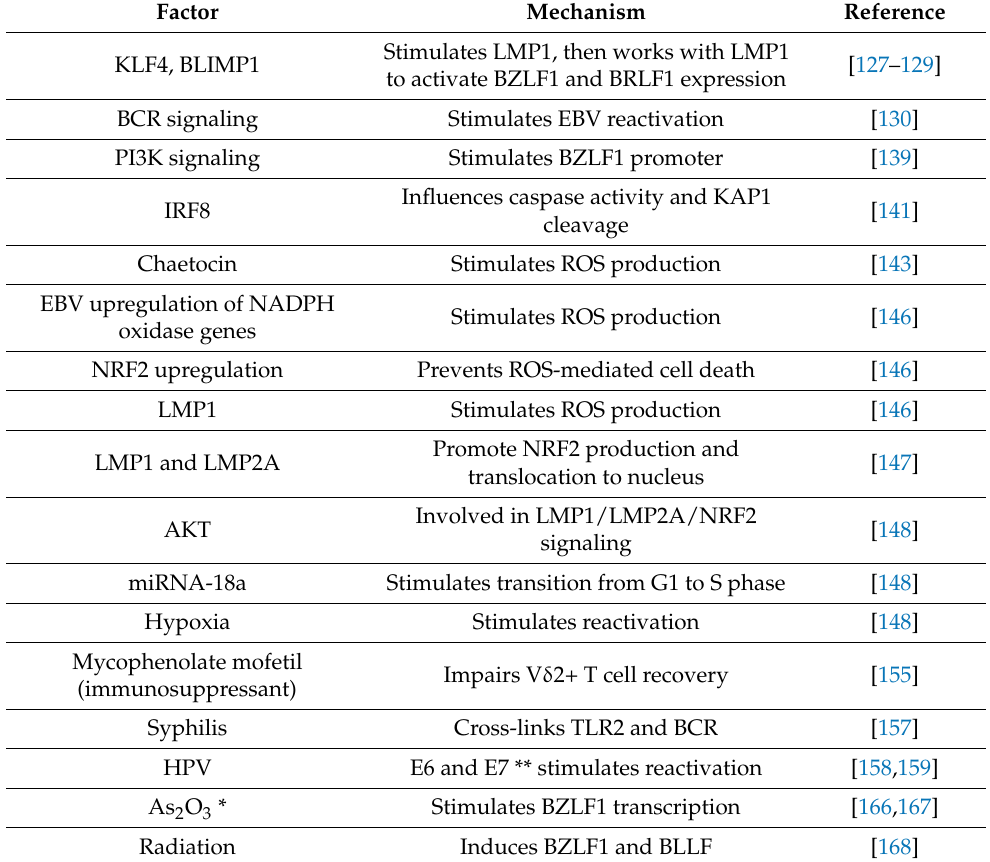
Table 2. Stimulators of EBV